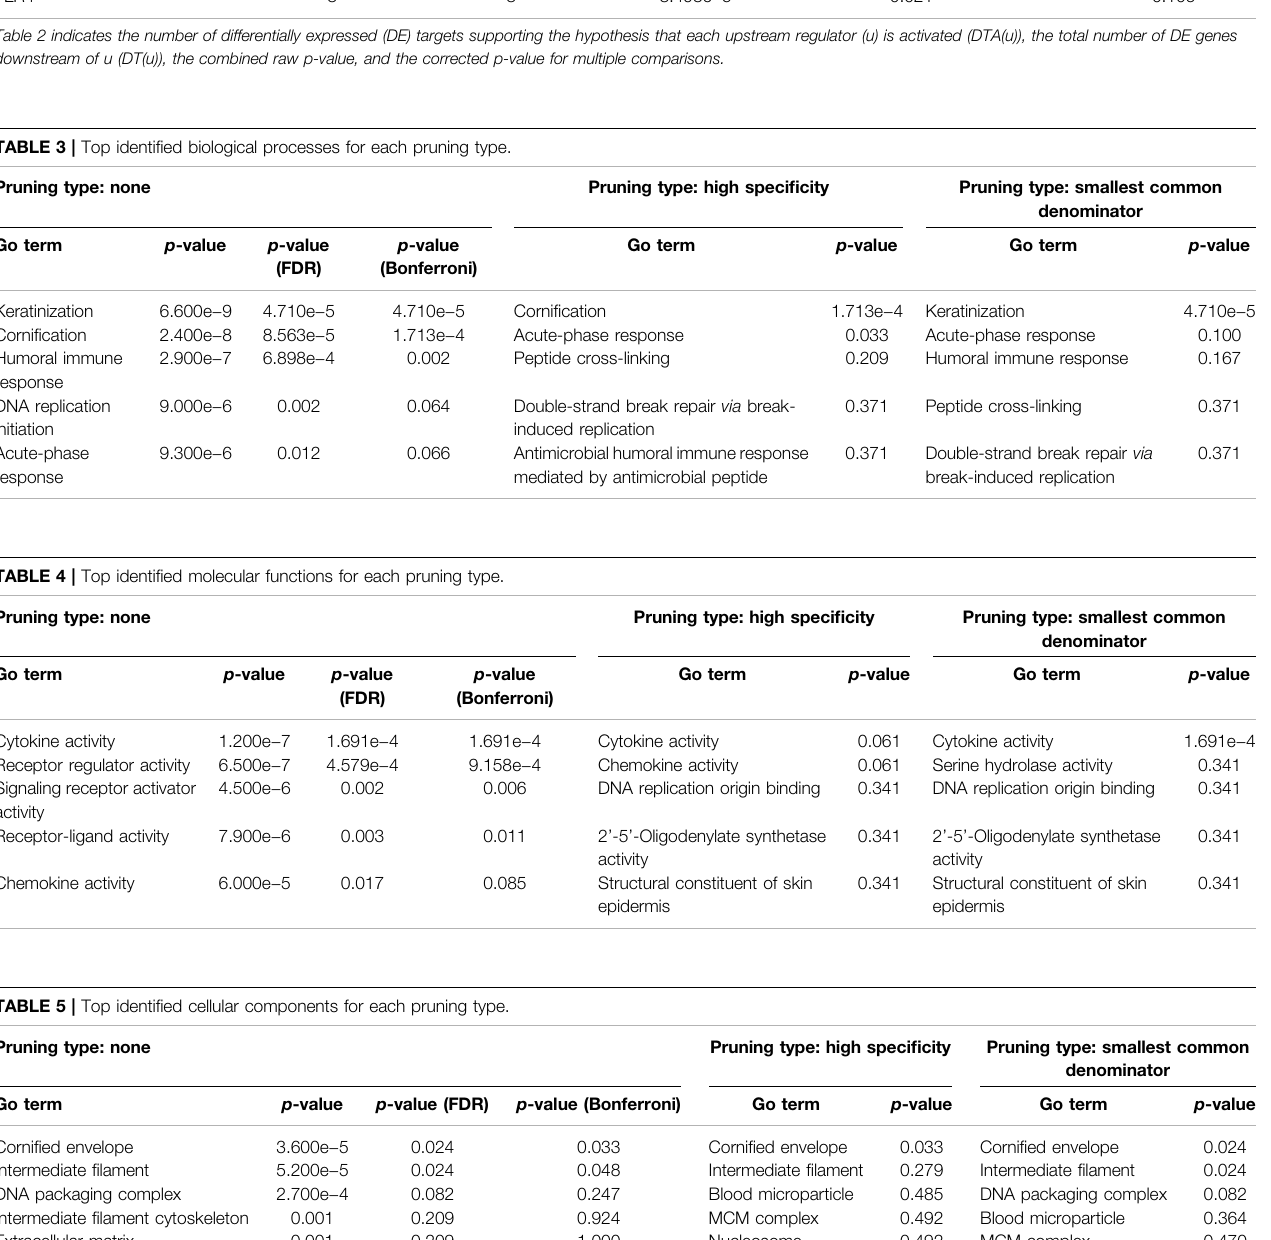
Table 2 indicates the number of differentially expressed (DE) targets supporting the hypothesis that each upstream regulator (u) is activated (DTA(u)), the total number of DE genes downstream of u (DT(u)), the combined raw p-value, and the corrected p-value for multiple comparisons.